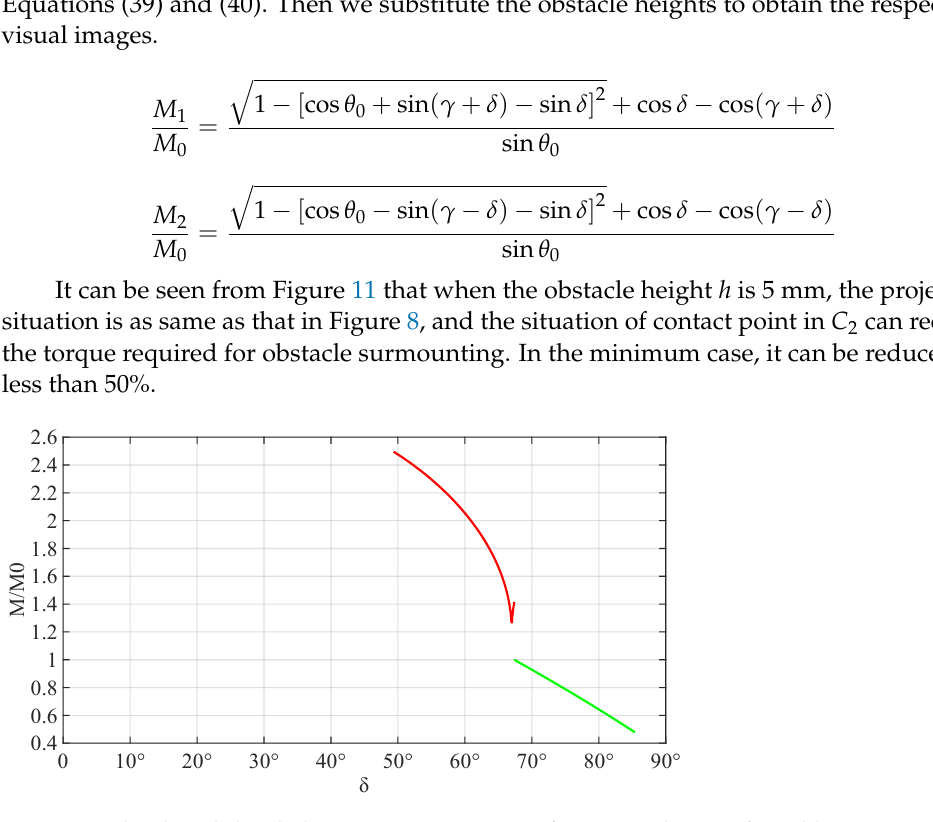
Figure 11. The obstacle height h is 5 mm. Comparison of torque under transformable state C 1 and C 2 M / M 0 (Red: C 1 ; Green: C 2 ).